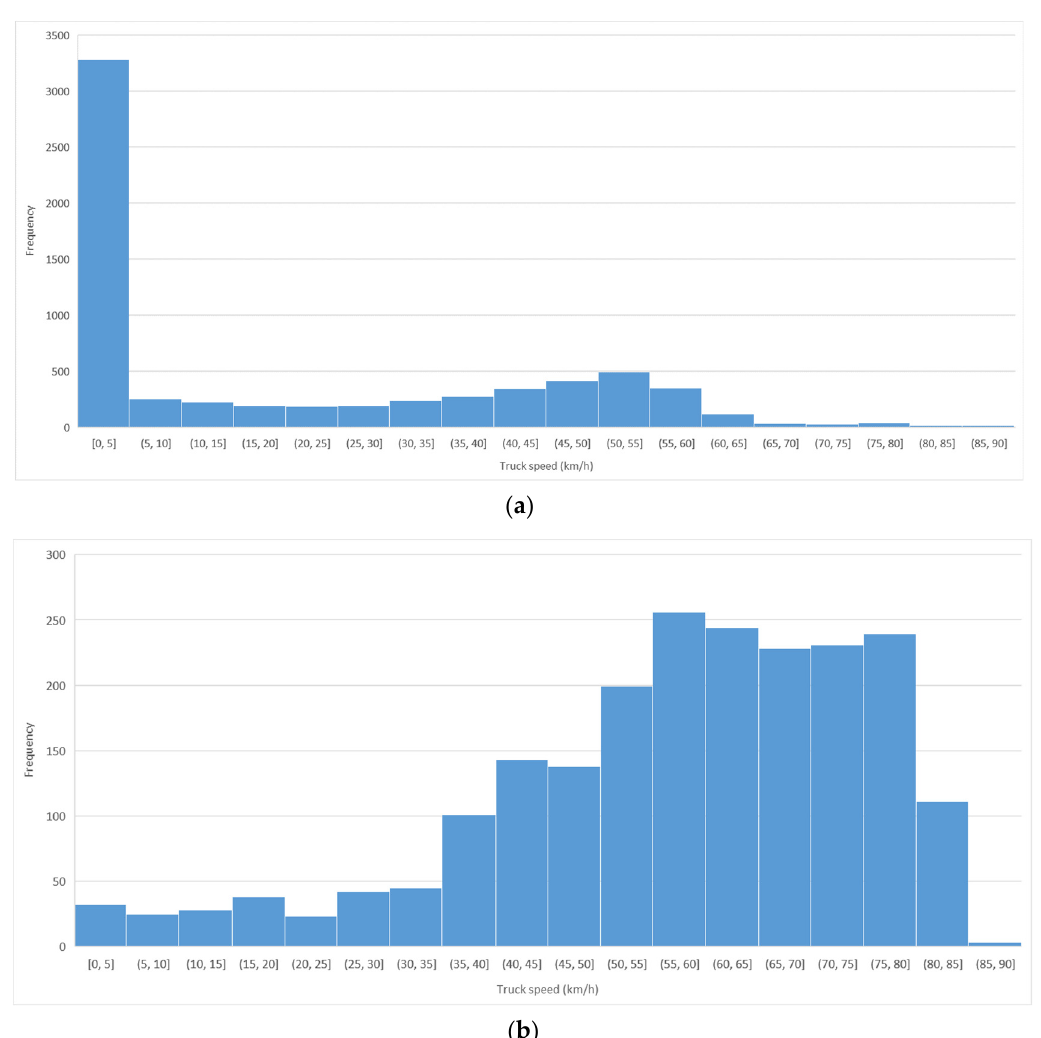
Figure 4. Distribution of truck speeds on ( a ) urban roads; ( b ) open roads within the city environment. Data from GPS from the truck.